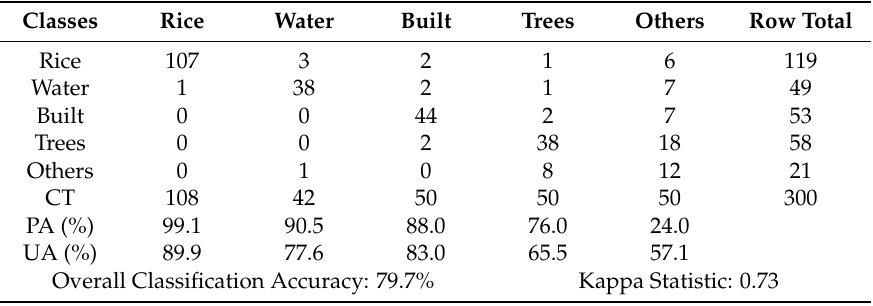
Table 5. Error matrix of accuracy assessment of classification with Sentinel-1A VH images.